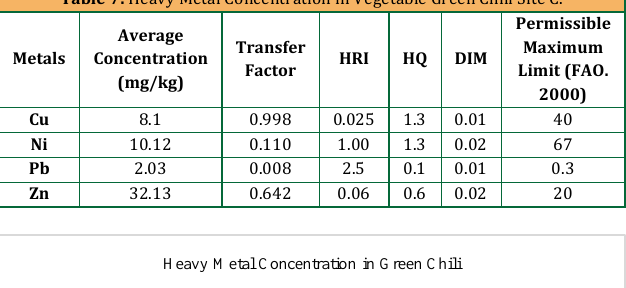
Table 7: Heavy Metal Concentration in Vegetable Green Chili Site C.